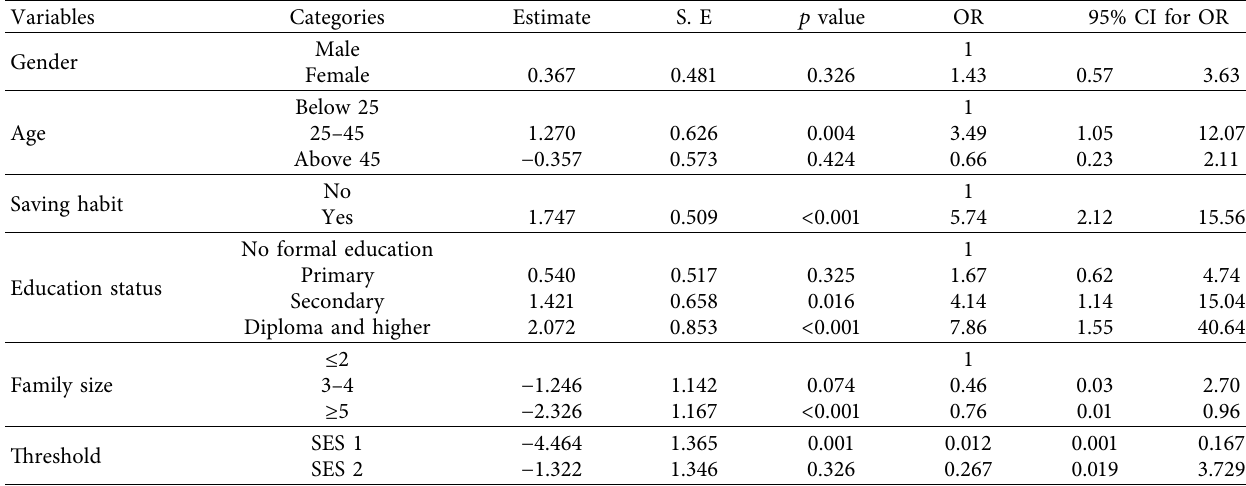
Table 3: Parameter estimates of PPOM using SES as response with three-ordered categories.